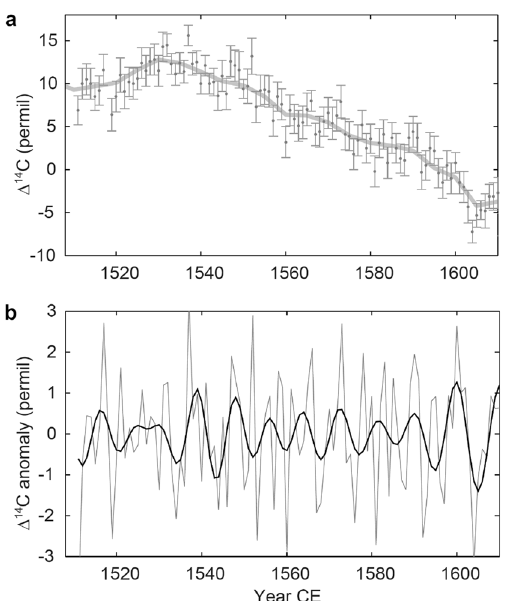
Figure 2. Annual record of carbon-14 before the Maunder Minimum. ( a ) Annual carbon-14 data for 1511–1610 CE obtained by Stuiver, Reimer, and Braziunas 21 (black dots), and the 5-year-resolution record of IntCal13 22 (gray, thick curve). ( b ) Band-pass-filtered carbon-14 data in ( a ) with the bandwidth of 8–15 years (thick curve) and 1–15 years (gray